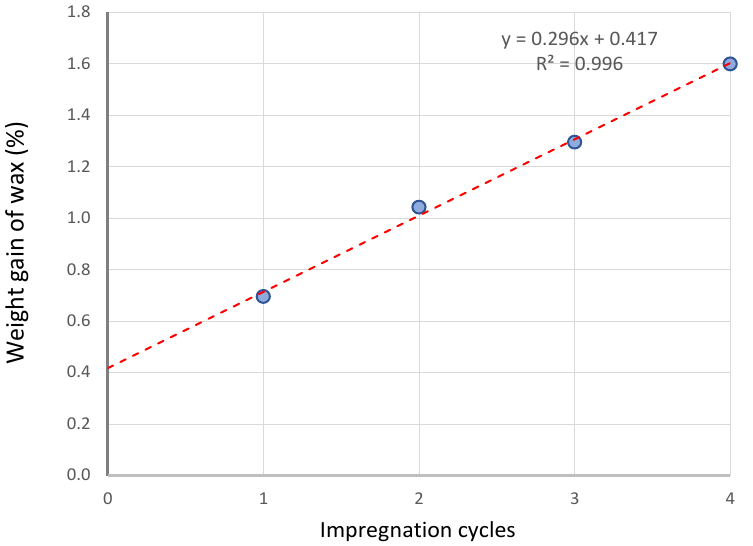
Figure 9. Weight gain after successive extraction/impregnation cycles with CO 2 , ethanol and oven- drying between cycles.